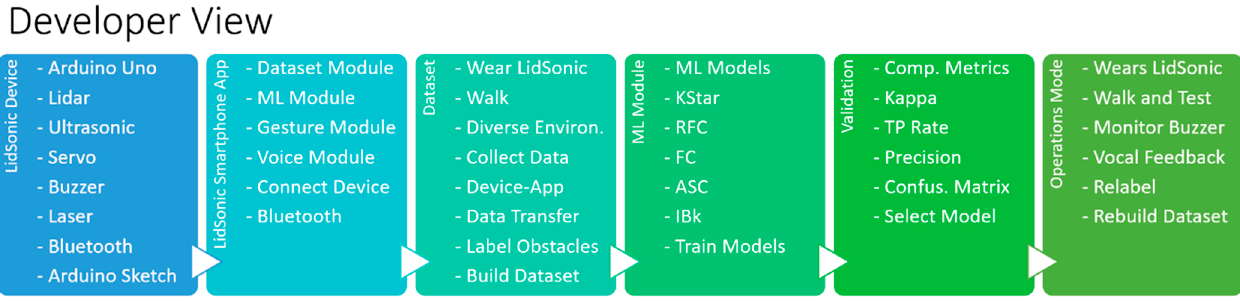
Figure 3. The steps a developer takes to build and test the LidSonic